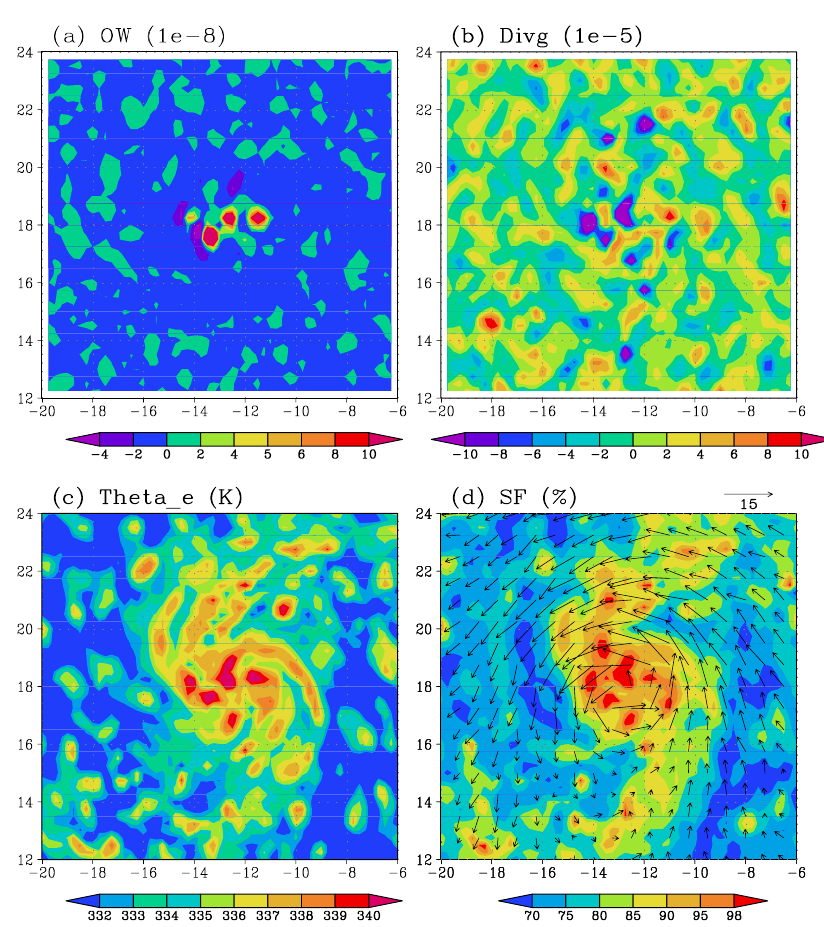
Fig. 9. OW ( a , unit: 10 − 8 s − 2 ) , divergence ( b , unit: 10 − 5 s − 1 ) , θ e (K) (c) , saturation fraction from the surface to 500mb (shading in d ), and wind field (vectors in d). The ordinate is latitude and the abscissa is longitude.